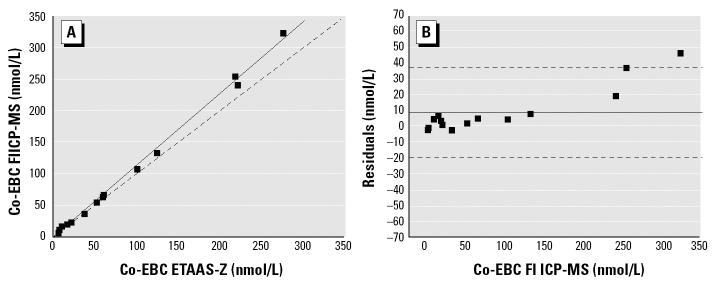
Correlation (A) and Bland-Altman graph (B) of the comparison between ETAAS-Z and FI ICP-MS techniques for the measurements in 12 EBC samples. In (A), the solid line represents the best fit of experimental values, and the dashed line shows the theoretical identity line. In (B), the solid line shows the mean deviation between the two methods; dashed lines indicate the mean ± 2 SD. A = –3.08381 ± 2.28647; B = 1.14266 ± 0.01921; R = 0.99817; p < 0.0001.